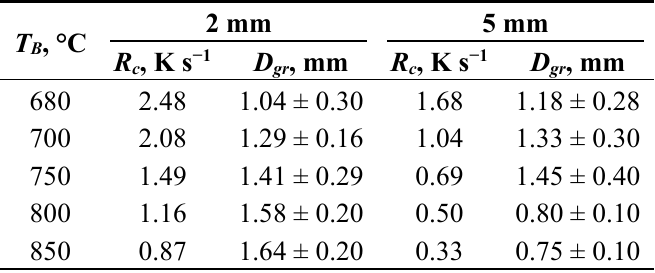
Table 1. R c and D gr of different beginning temperatures ( T B ) for the two geometries of thin-walled